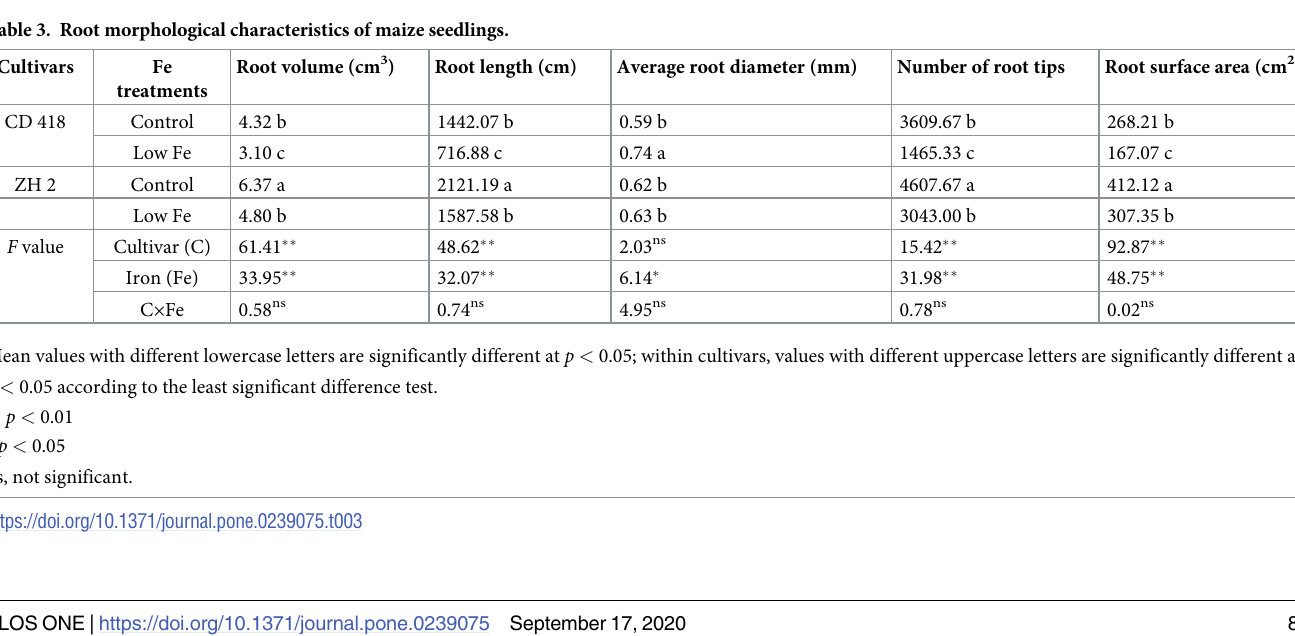
The root volume, root length, number of root tips, and root surface area of maize seedlings were significantly lower in the low Fe treatment compared with the control, whereas the aver- age root diameter was increased and there were obvious differences between cultivars (Table 3). Under low Fe stress, the root volume, root length, number of root tips, and root sur- face area of ZH 2 decreased by 24.73%, 25.16%, 33.96%, and 25.42%, respectively, and the aver- age root diameter increased by 1.30%, while those of CD 418 changed by 28.09%, 50.29%, 59.41%, 37.71%, and 25.13%, respectively. Variation in root volume, root length, number of root tips, root surface area, and average root diameter of the Fe-efficient cultivar ZH 2 was sig- nificantly lower than in the Fe-inefficient cultivar CD 418. The root volume, root length, num- ber of root tips, and root surface area of ZH 2 were significantly higher than those of CD 418 under both control and low Fe treatments. They were higher by 47.66%, 47.09%, 27.65%, and 53.66% respectively under the control treatment, and higher by 54.55%, 121.46%, 107.67%, and 83.97%, respectively under the low Fe treatment. The differences in root morphological characteristics between the two cultivars in the low Fe treatment were significantly higher than those under the control treatment. Compared with CD 418, ZH 2 maintained higher root growth under low Fe stress than CD 418, thereby improving its adaptability to a low Fe environment.